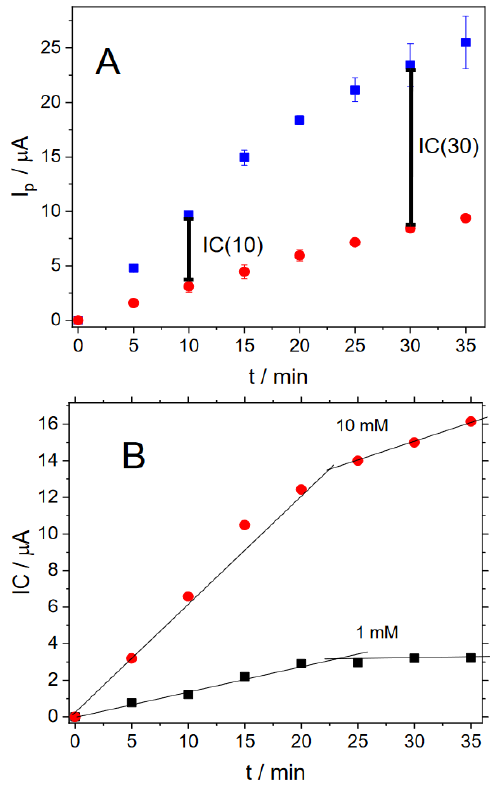
Figure 4. ( A ) Evolution of the oxidation peak current intensity recorded during the cyclic voltammetry in trizma buffer solution (pH = 8.4) + 0.5 mM HQ2P in the absence of (blue squares) and presence of PO 43 − 10 mM (red circles). ( B ) Inhibition current ( IC ) obtained at different times of measurement for different concentrations of phosphate: 10 mM PO 43 − (red circles) and 1 mM PO 43 − (black squares).